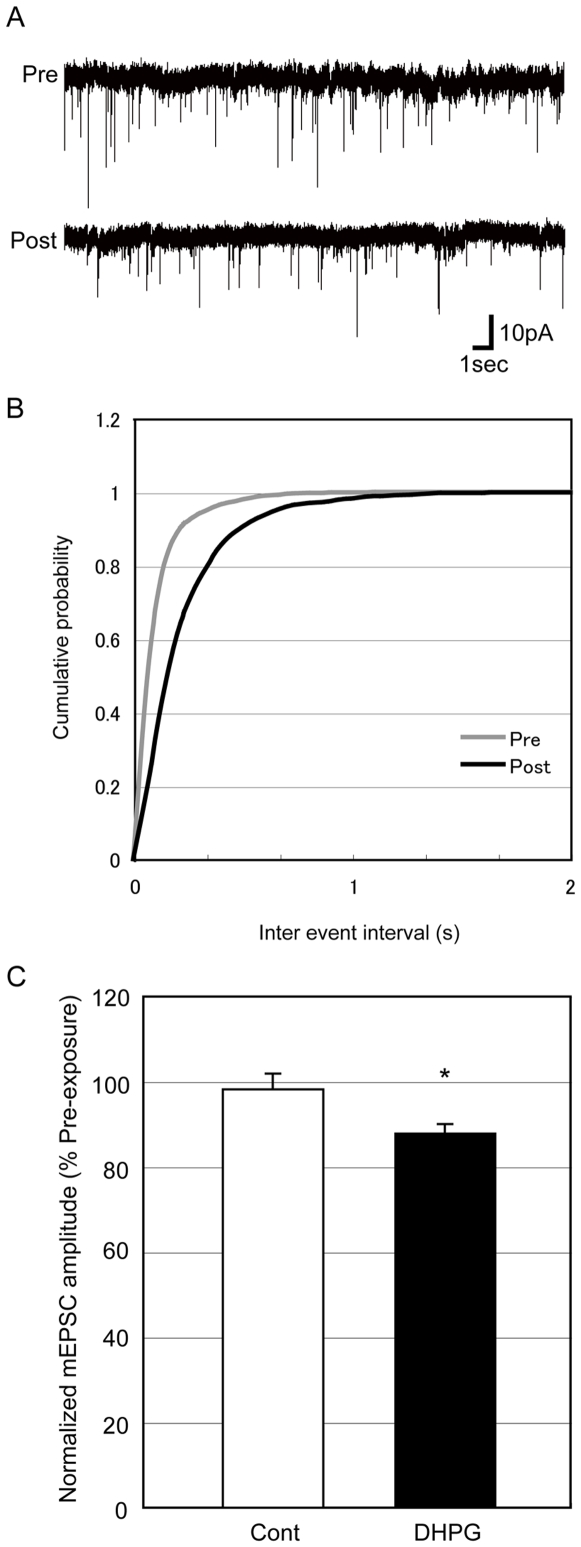
DHPG exposure of cultured hippocampal neurons for 10 min results in LTD of mEPSC amplitude.(A) Representative traces of mEPSCs before (Pre) and 30 min after (Post) exposure to DHPG. (B) Cumulative probability of mEPSC 10-0 min before (Pre) and 20–30 min after (Post) DHPG treatment. *p<0.05 using the Kolmogorov-Smirnov test (n = 9 cells per group) (C) Summary of average change in mEPSC amplitudes. Miniature EPSCs recorded over a 10 min period 30–40 min after DHPG exposure and mock stimulation (Cont) were measured and compared with those collected before exposure (n = 9 cells per group). Error bars indicate SEM; *p<0.05, Student's t-test.